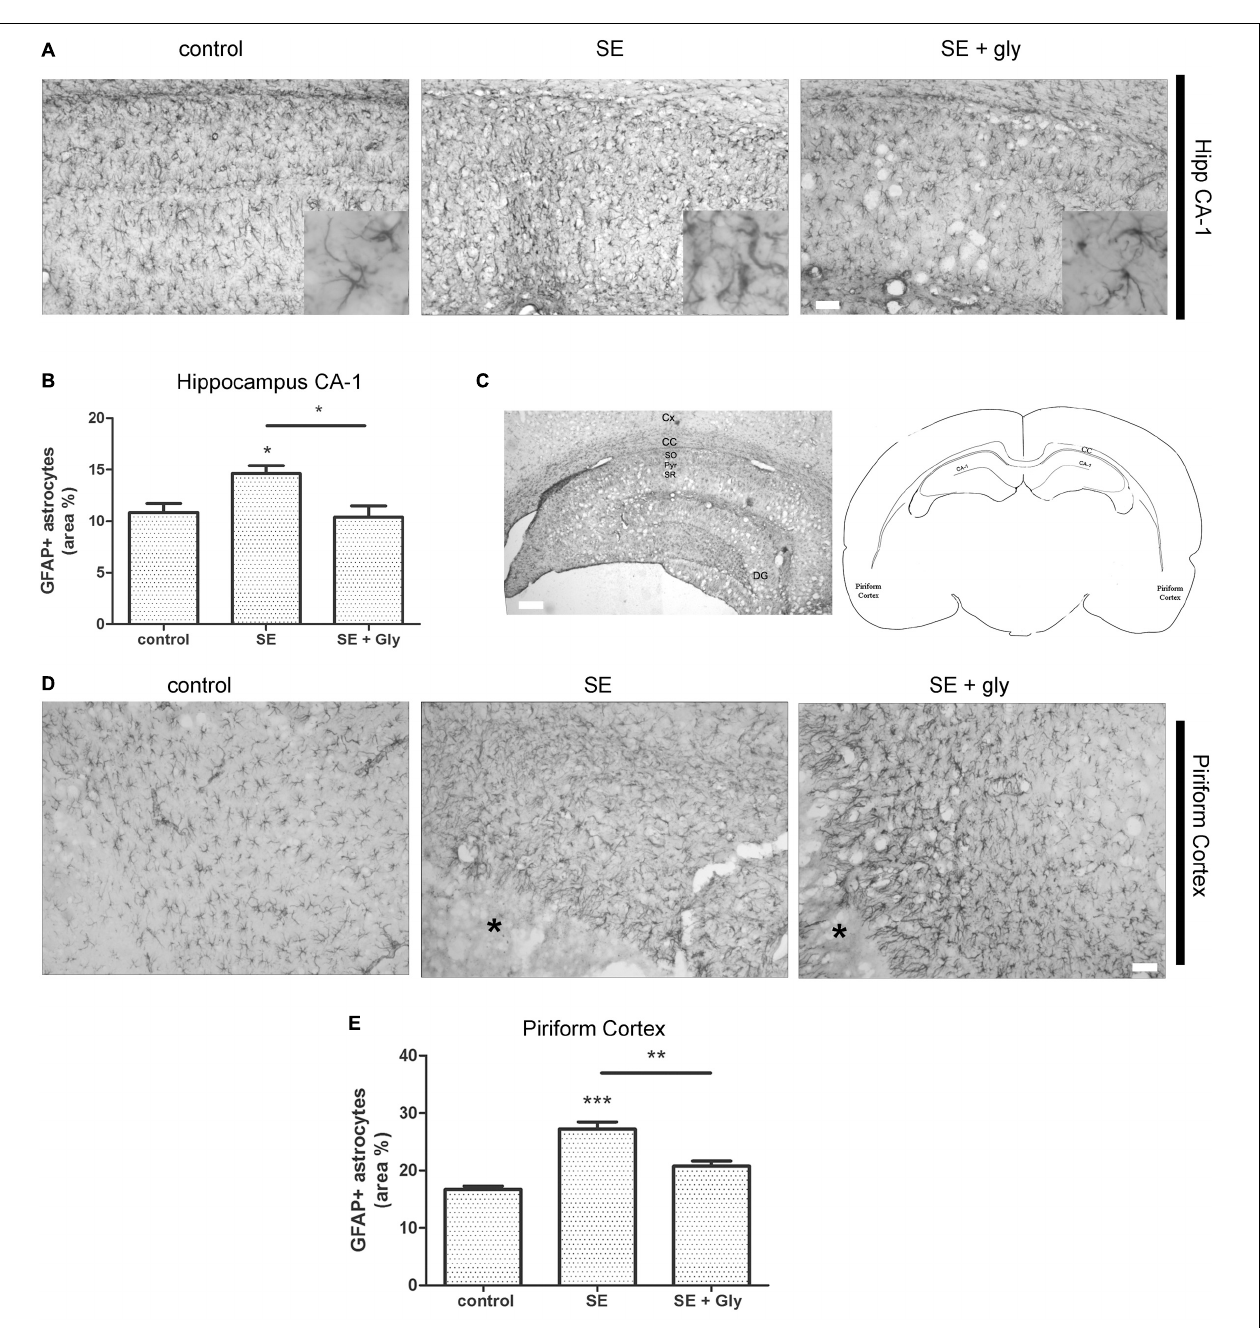
FIGURE 8 | HMGB-1 antagonist glycyrrhizin reduces reactive astrogliosis after pilocarpine-induced SE. Rats were exposed to pilocarpine-induced SE, treated with glycyrrhizin or vehicle for 4 days and analyzed after 15 days. (A) Representative images of GFAP-immunostained astrocytes showing the CA-1 hippocampal area. The insets depict astroglial cell morphology in detail. Note the increased astroglial hypertrophy with enlarged projection and increased soma size in SE-exposed animals and the decreased hypertrophy in SE glycyrrhizin-treated animals. Scale bar: 30 µ m. (B) Quantitative analysis of the GFAP + astroglial cell morphology in the hippocampus of control, SE and SE animals treated with glycyrrhizin. (C) Low magnification of the GFAP-immunostained hippocampus to visualize the different regions (scale bar: 300 µ m) and a schematic representation of the analyzed areas in a coronal rat brain section. Cx, Brain cortex; CC, Corpus Callosum; DG, Dentate Gyrus; CA-1, Hippocampal CA-1 area; SR, Stratum Radiatum; SO, Stratum Oriens; Pyr, Pyramidal neurons. (D) Representative images of GFAP-immunostained astrocytes in the piriform cortex. Note the necrotic core ( ∗ ) that is characteristic of SE-exposed animals surrounded by highly hypertrophied astrocytes. Scale bar = 35 µ m. (E) Quantitative analysis of GFAP-immunostained cell area in the piriform cortex and hippocampus of control, SE and SE animals treated with glycyrrhizin. Statistical analyses were performed by one way ANOVA and Student Newman–Keuls post-test, with statistical significance represented as ∗ p < 0.05, ∗∗ p < 0.01, and ∗∗∗ p < 0.001. Control animals were exposed to lithium chloride and saline was used as vehicle. The number of animals were n = 6 per experimental group.